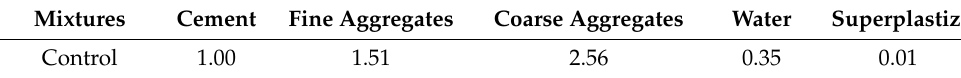
Table 3. Technical details of the used superplasticizer.